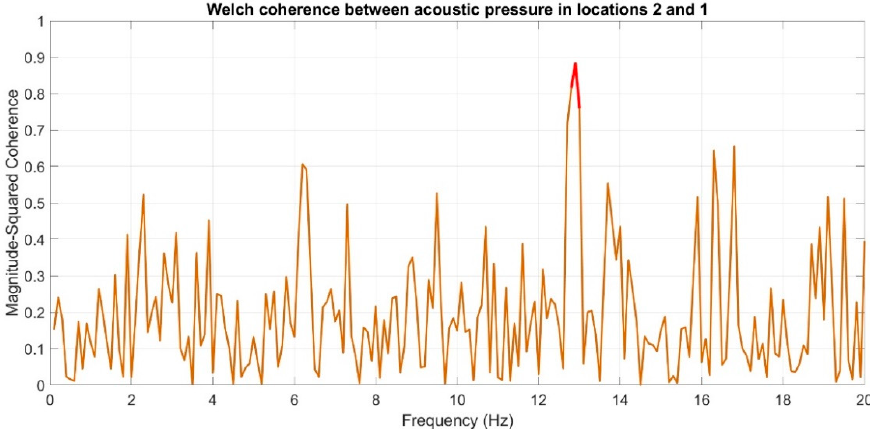
Figure 16. Welch power spectral densities estimated for acoustic pressure acquired in three different locations at the same time: orange color—measuring setup number 1; blue color—measuring setup number 2 and green color—measuring setup number 3.